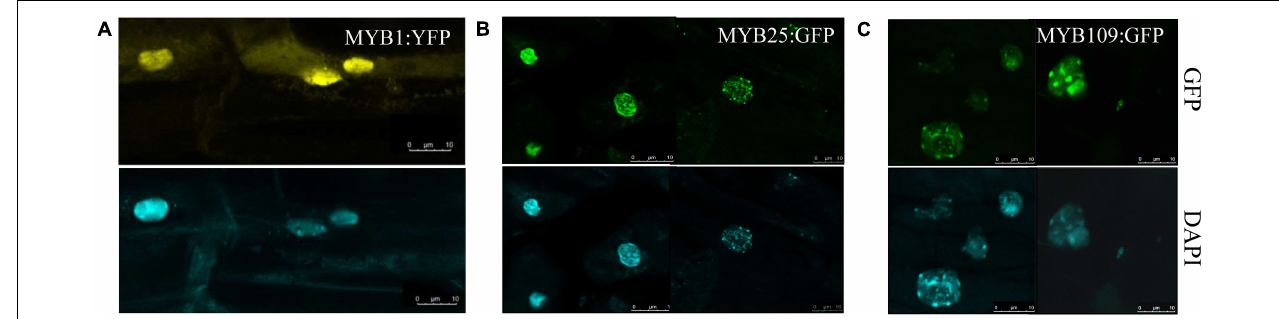
FIGURE 5 | MYB1, MYB25, and MYB109 are localized in the nucleus. Expression analysis in transgenic Arabidopsis thaliana showed that YFP-tagged MYB1 (A) , or GFP-tagged MYB25 (B) and MYB109 (C) proteins are localized in the nucleus. 4 (cid:48) ,6-diamidino-2-phenylindole (DAPI) images are included to indicate the location of the